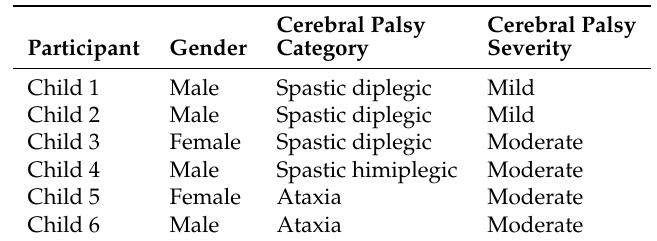
Table 2. The gender, cerebral palsy category, and cerebral palsy severity of the children included in the first group of